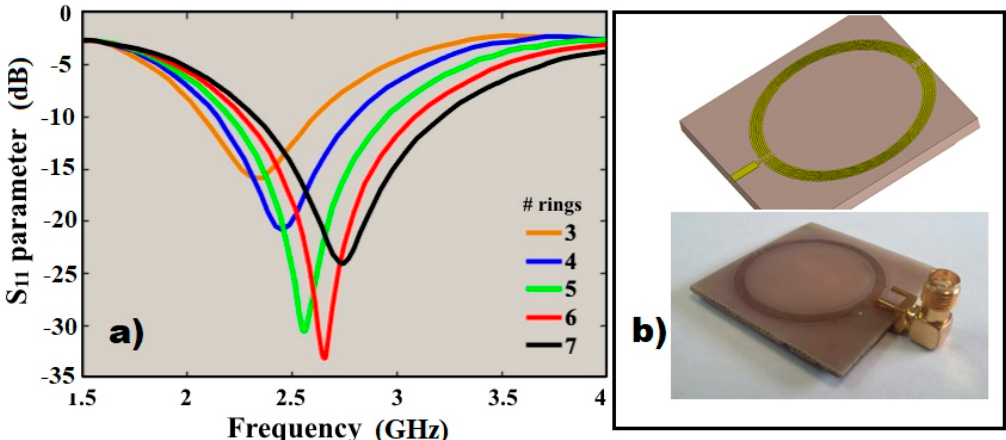
Figure 2. ( a ) Simulation of return loss profiles for the metamaterial sensor as a function of the inner SRR number. ( b ) Illustrations of SRR with three rings for simulation and the built design.